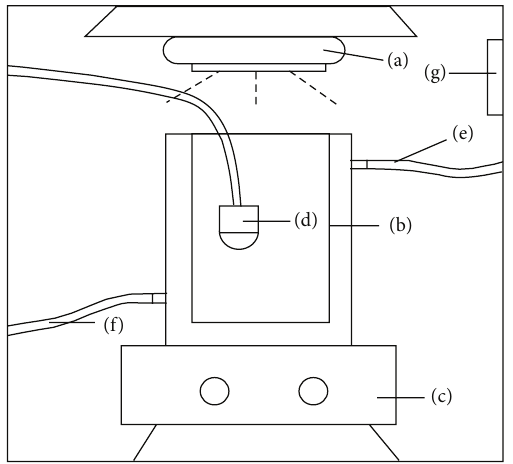
Figure 1: Photoreaction chamber. (a) Xenon lamp, (b) double-deck beaker, (c) magnetic stirrer, (d) oxygen pump, (e) outlet, (f) inlet, and (g) fan. Figure 2: Control experiment. (a) Light+ NBH, (b) NBH alone, (c) light alone, and (d)